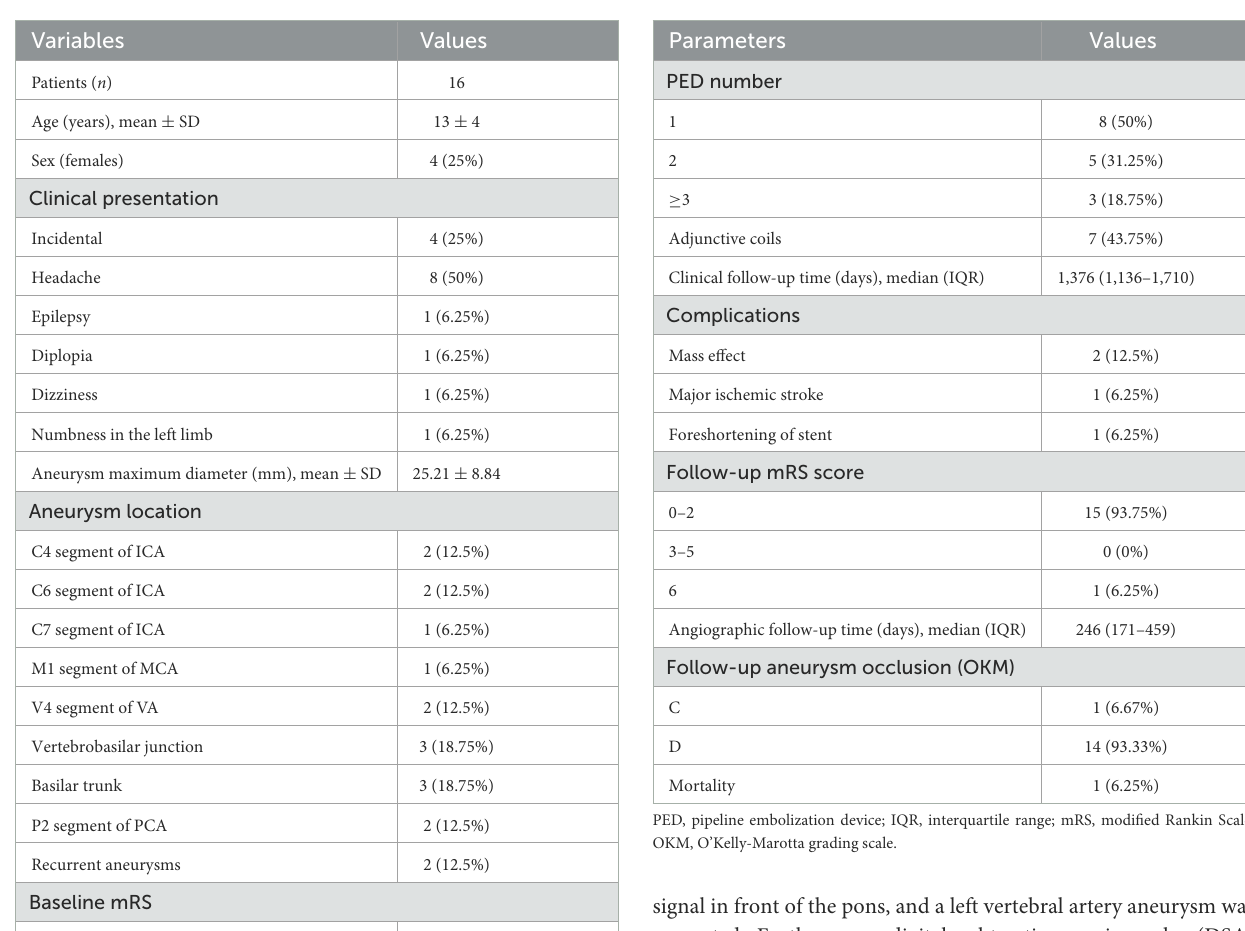
TABLE 1 Patient demographics and aneurysm characteristics. TABLE 2 Procedural details and follow-up